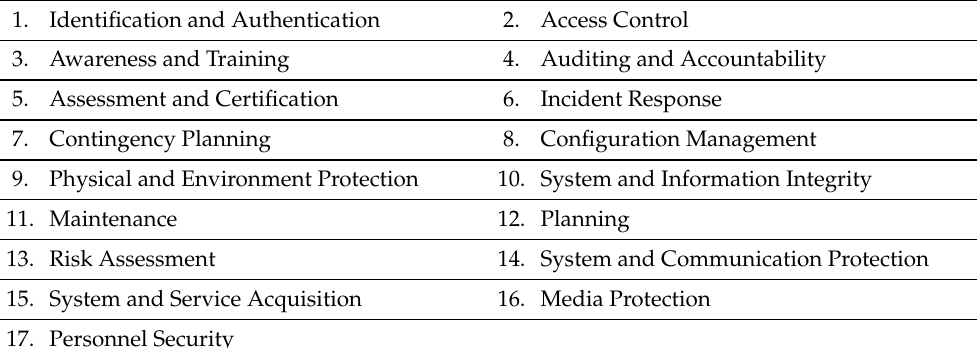
Table 3. 17 Control Areas of NIST FIPS 200.